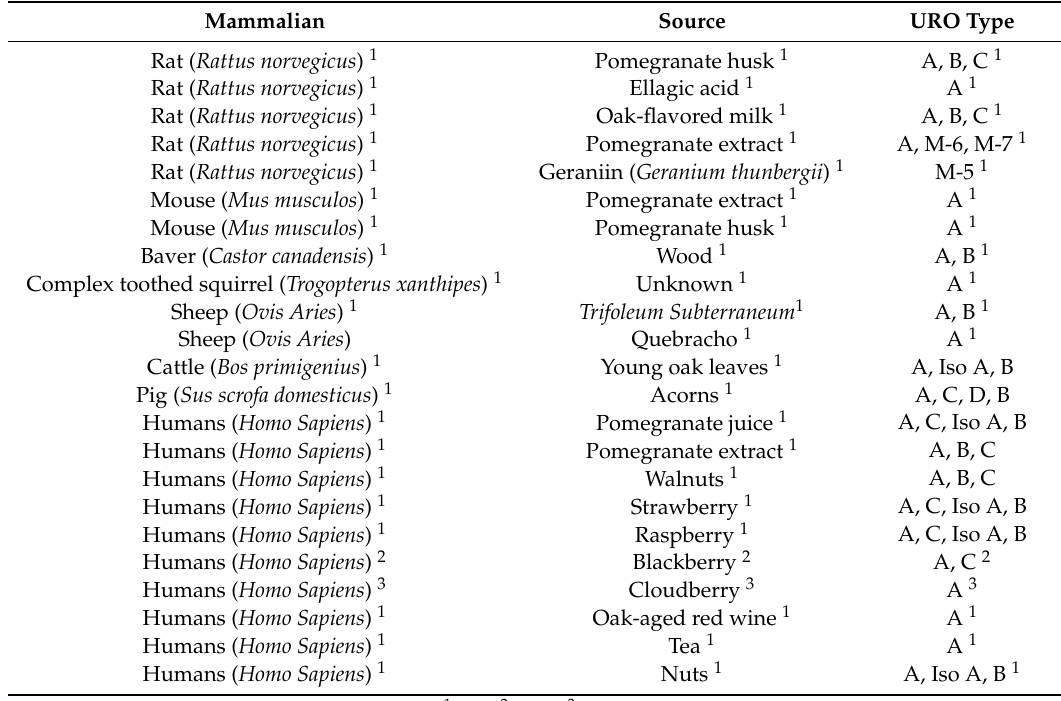
Table 11. Production of UROs in di ff erent mammalian